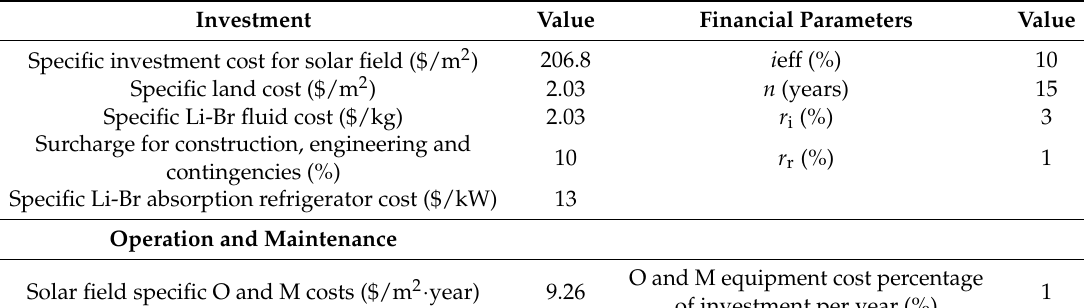
Table 9. Cost assumption data used for the economic analysis.